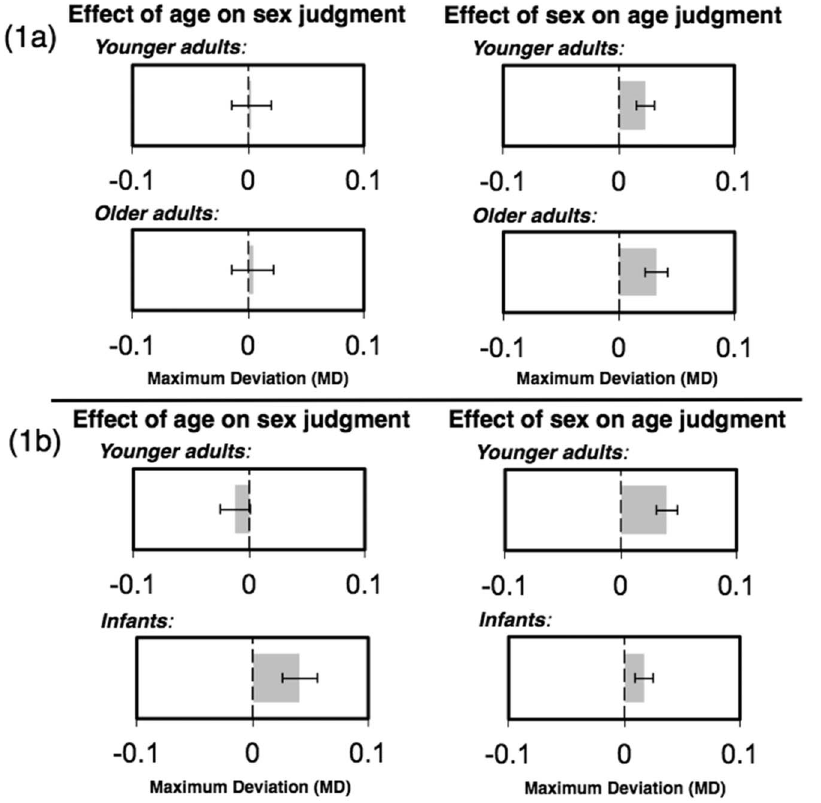
Figure 3. Top: Graphical display of the maximum deviation scores (MD) when categorizing older adults and younger adults faces as a functions of either their sex (left) or their age (right). Bottom: Graphical display of maximum deviation scores (MD) when categorizing infant and younger adults faces as a functions of either their sex (left) or their age (right).